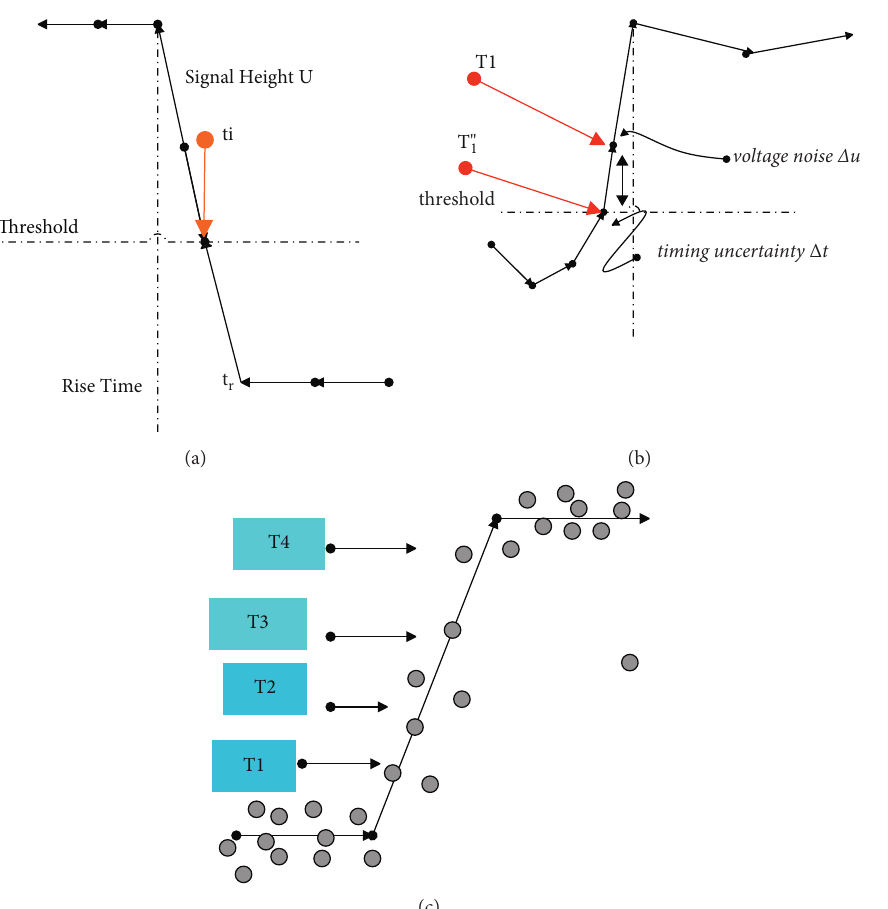
Figure 1: Schematic diagram of time accuracy calculation. (a) Ideal situation. (b) Voltage noise. (c) Multiple sampling points on the leading